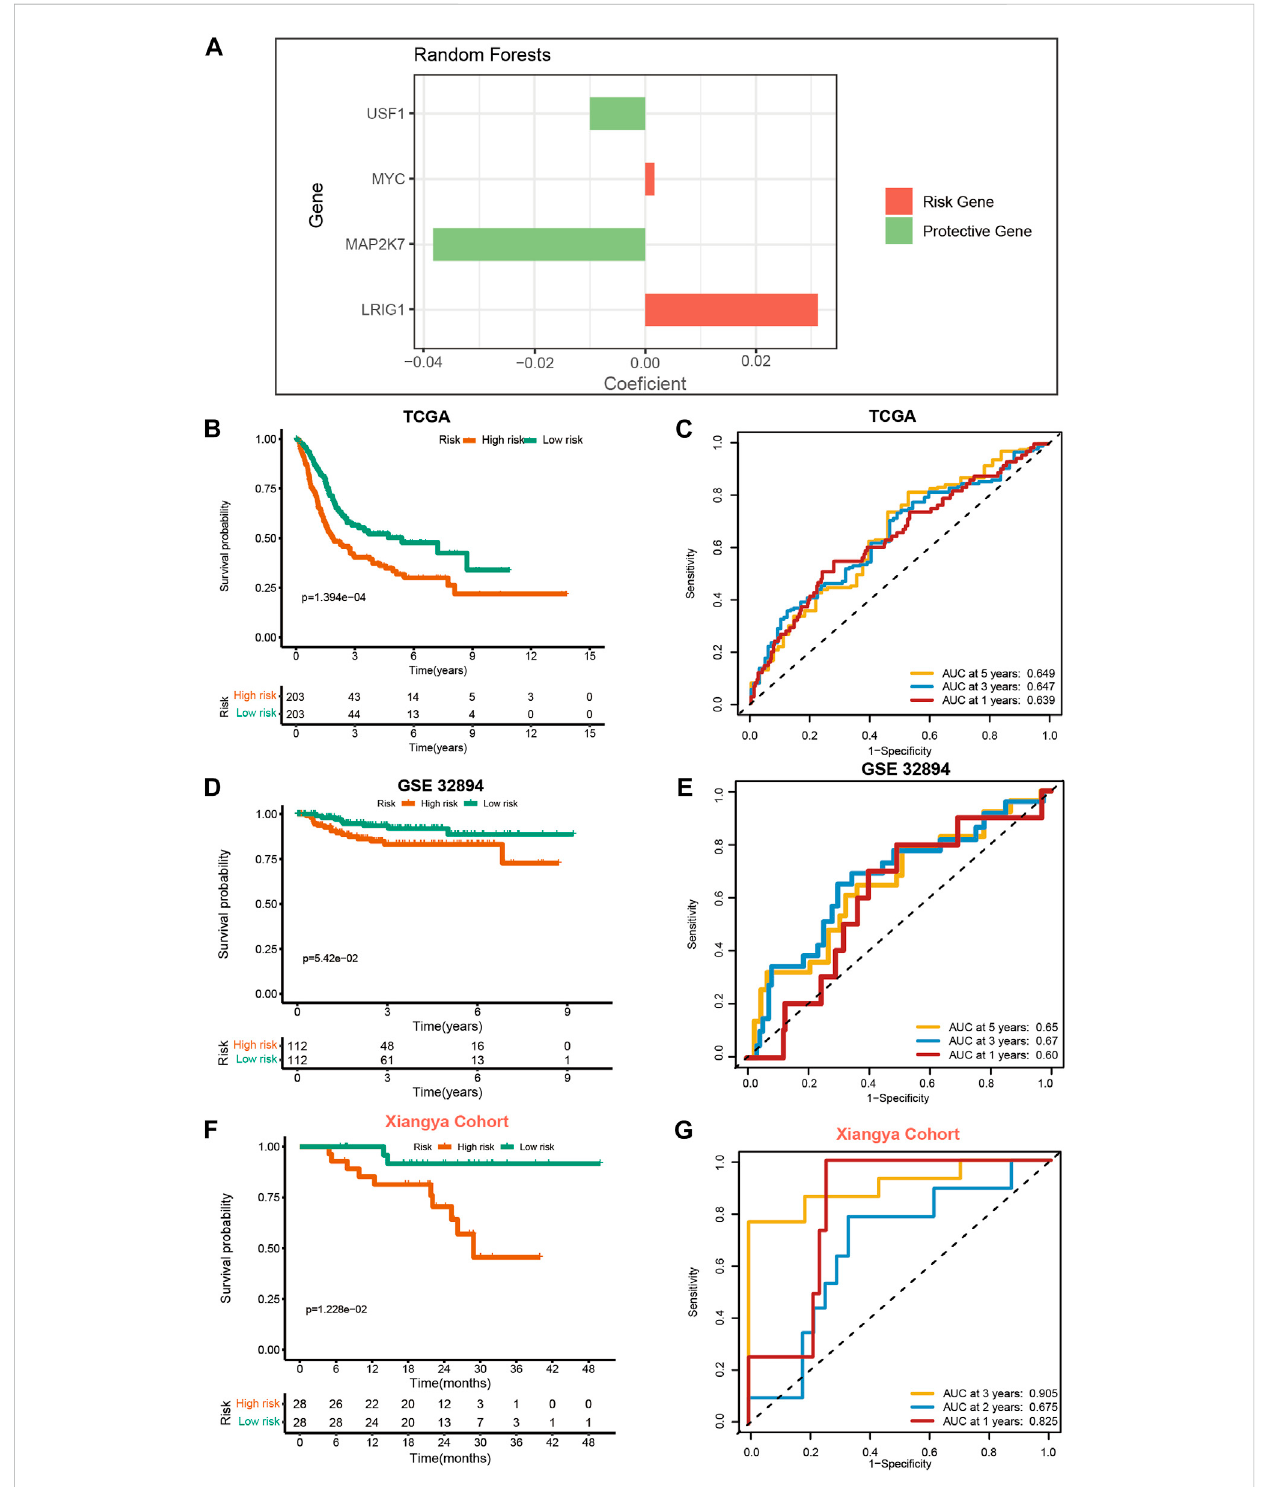
FIGURE 2 Development and validation of VM_Score in multiple BLCA cohorts. (A) Four best candidates were screened by random forest algorithm to determinethegenerationofVM_Score. (B) Kaplan – MeieranalysisofOSforVM_ScoreinTCGA-BLCAcohort. (C) ROCcurvesofVM_Scoreforpredicting OS in TCGA-BLCA cohort. (D,E) Validation of VM_Score in GSE32894. (F,G) Validation of VM_Score in Xiangya